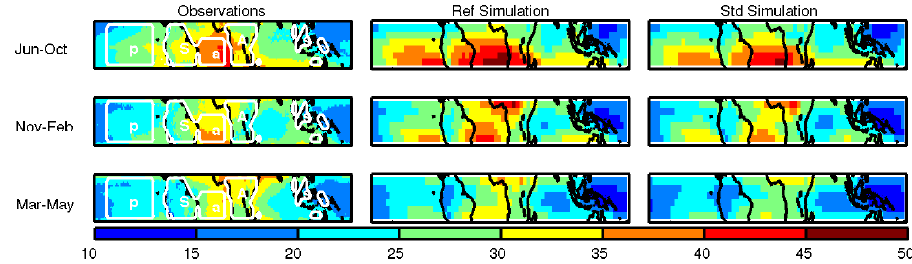
Fig. 1. OMI/MLS tropospheric column ozone in Dobson units (Ziemke et al., 2006) compared with simulated tropospheric column ozone in the new reference simulation (cf. Sect. 3.1) and in a standard simulation where ING 0 is a terminal sink of NO x . The different geographical regions used in this study are denoted by white contours. The tropical region extends from 15 ◦ S to 7 ◦ N. Top row: June 2006–October 2006, middle row: November 2006–February 2007, bottom row: March 2007–May